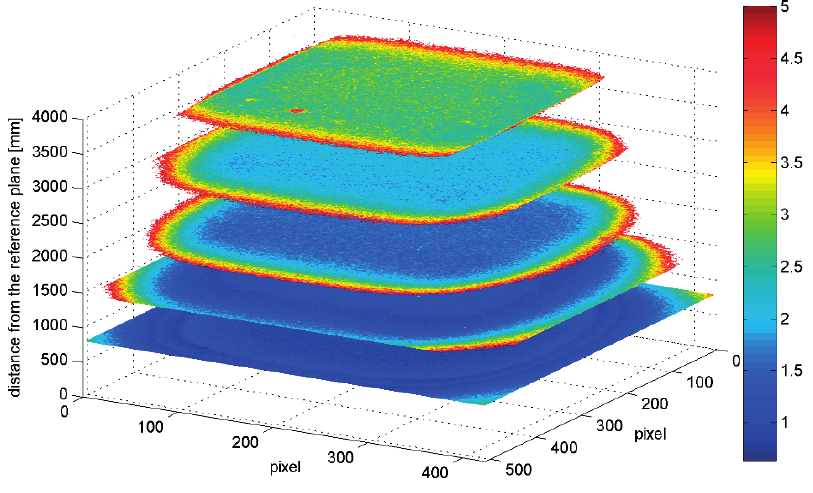
Figure 12. Standard deviation (mm) of the corresponding pixels computed considering images acquired at different distances from a flat surface. The x and y -axis represent the image frame, while along the z -axis the distances from the reference plane are reported. The color scale represents the standard deviation